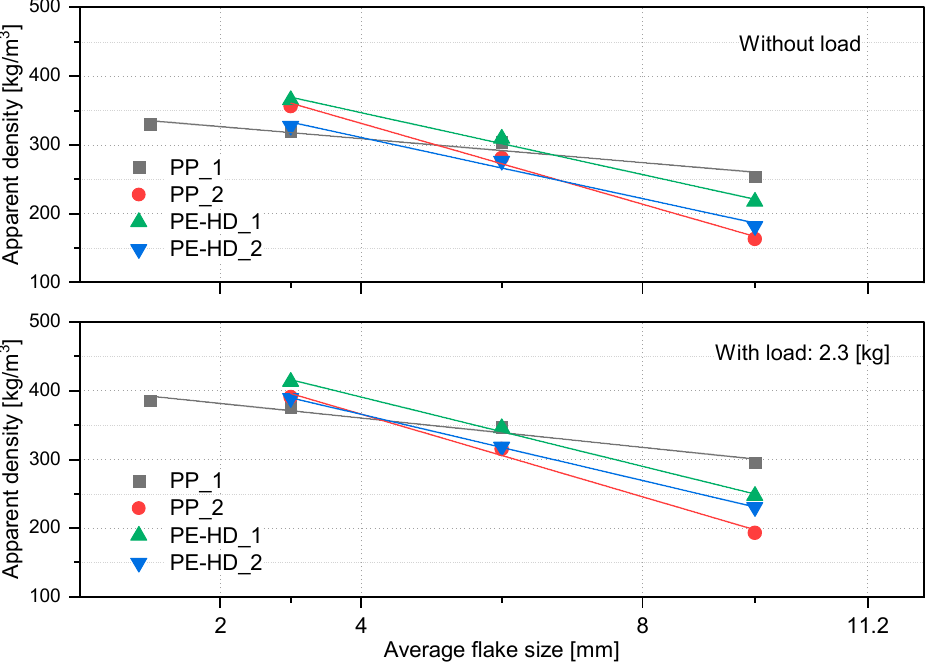
Figure 12. A correlation between the mean values of the flake size fractions and the corresponding AD values of the investigated size spans.